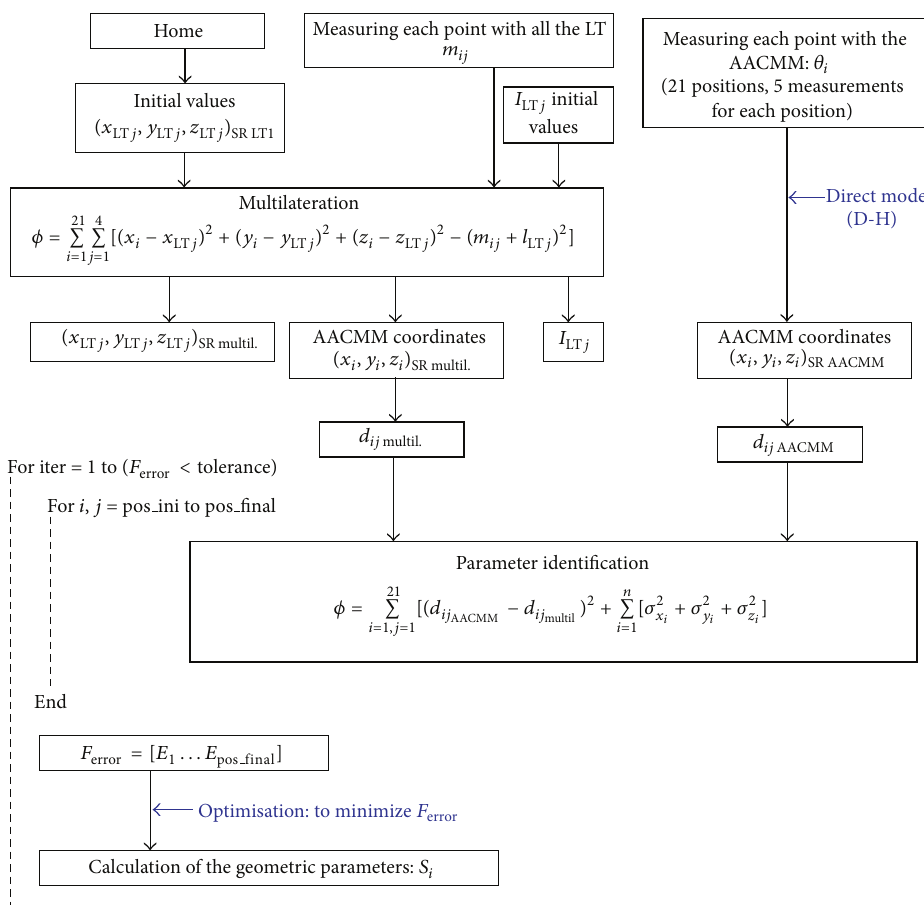
Figure 6: Scheme of the calibration